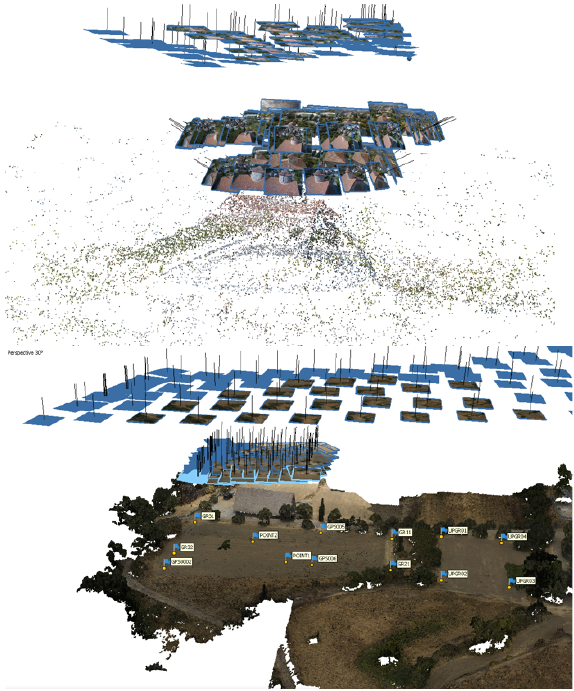
Figure 10. Timios Stavros, Pelendri, aerial surveys, sparse point cloud (top); Panagia tis Podithou, Galata, dense point cloud